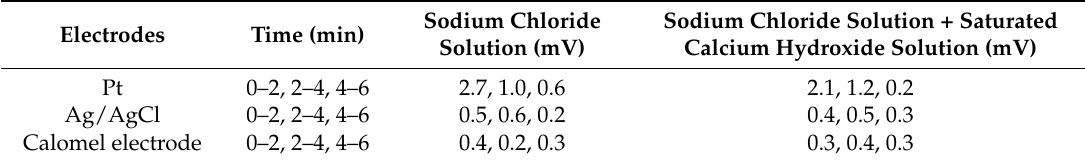
Table 3. Maximum relative potential shift of different reference electrodes.